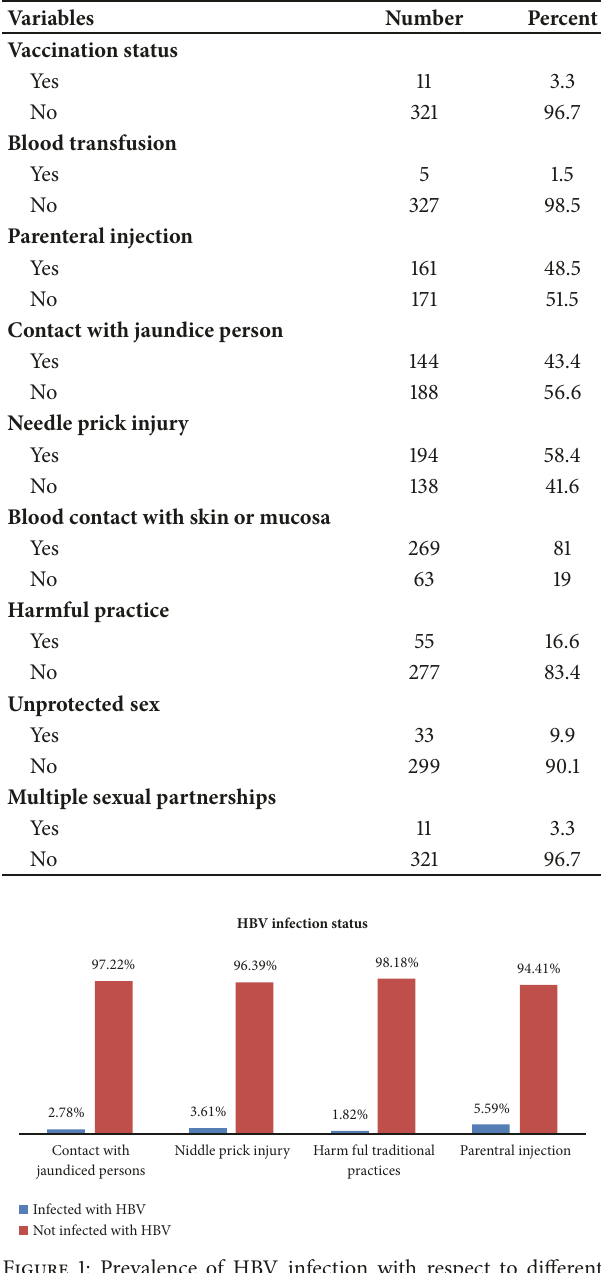
Table 1: Exposure to potential risk factors or HBV infection among HCWS at UOG hospital, Northwest Ethiopia, 2015.